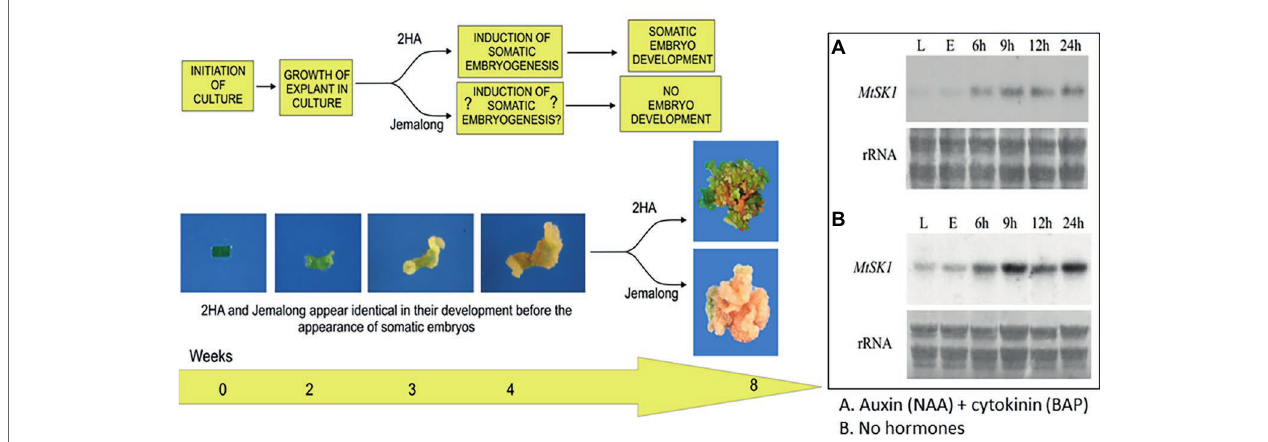
FIGURE 2 | Interactions between stress and hormones in somatic embryogenesis. Development of explants from 2HA and wild-type Jemalong. Jemalong leaf explants develop into calli while 2HA explants develop into embryogenic calli capable of producing regenerated plants. Inset shows MtSK1 expression (northern blots) in 2HA explants (E) from leaves (L) cultured for 24 h with and without hormones. Component figures reproduced from Nolan et al. (2006) with